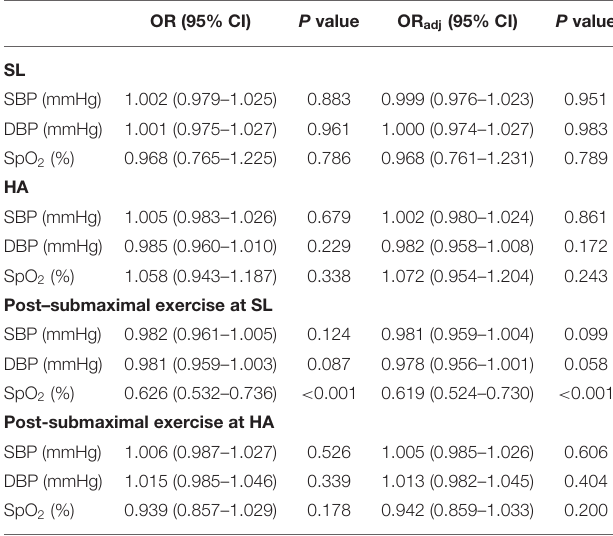
TABLE 4 | Regression analysis of physiological parameters with high-altitude